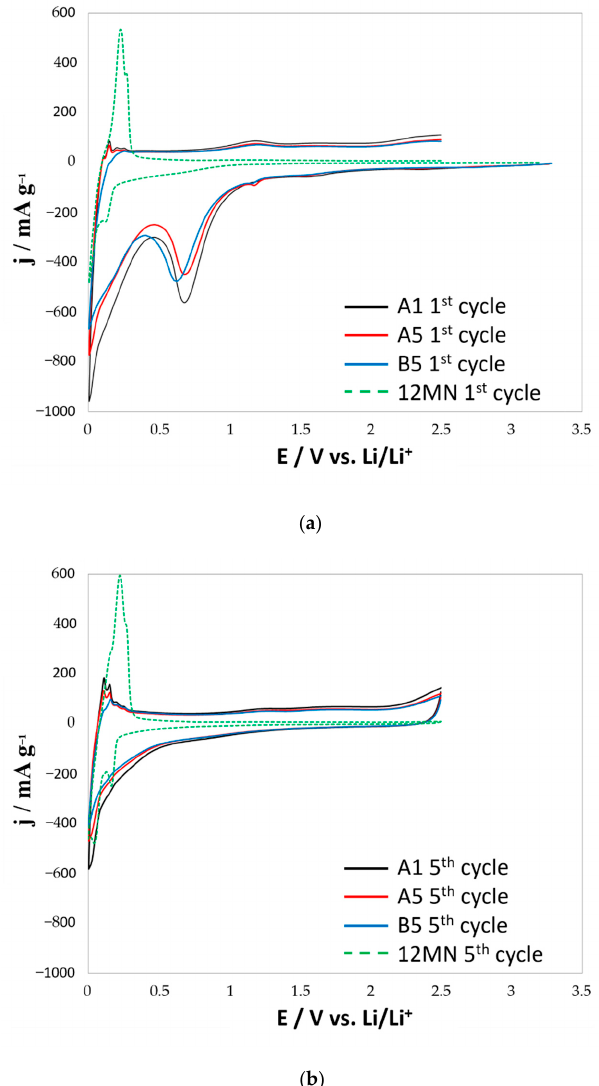
Figure 8. The first ( a ) and fifth ( b ) cycles of cyclic voltammetry for the tested materials and compara- tively for the unmodified material